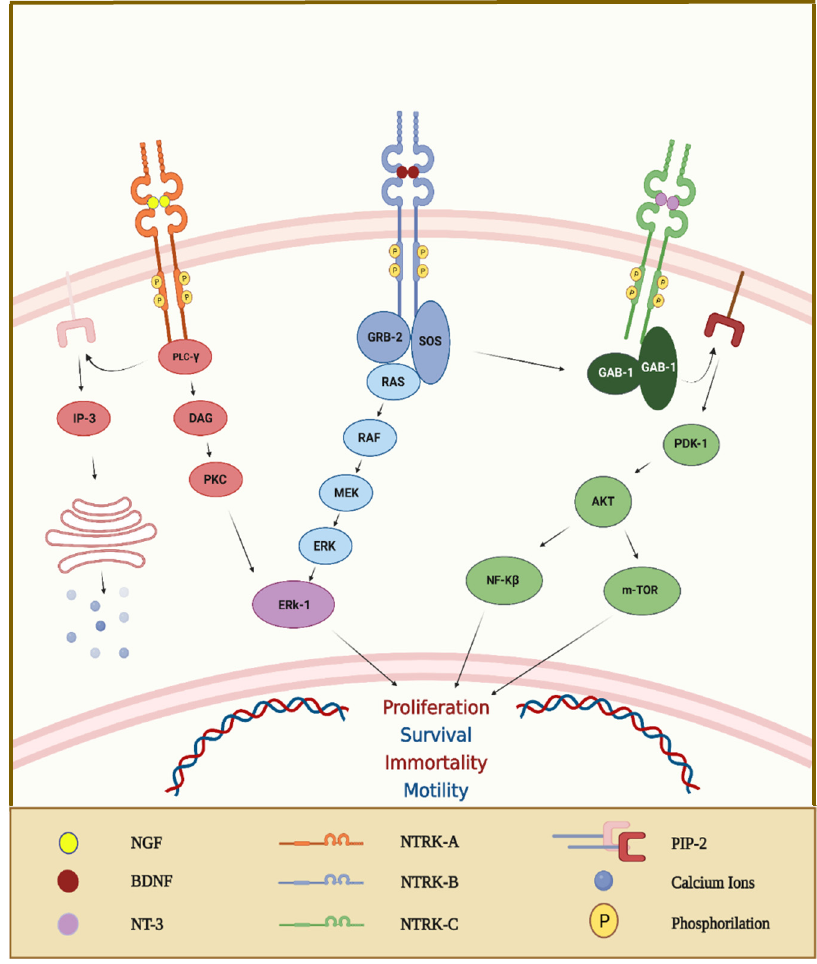
Figure 3. The interaction between ligands and TRK receptors generates TRK receptor dimerization, activating crosstalk between multiple intracellular signaling pathways involving PI3K and mitogen- activated protein kinase pathways. Abbreviations: protein kinase B (AKT); diacylglycerol (DAG); extracellular signal-regulated kinase (ERK-1); GRB2-associated binding protein-1 (GAB-1); growth factor receptor-bound protein-2 (GRB-2); inositol trisphosphate (IP-3); mitogen-activated protein kinase kinase (MEK); mammalian target of rapamycin (m-TOR); nuclear factor kinase- β (NF-K β ); 3-phosphoinositide-dependent protein kinase-1 (PDK-1); protein kinase C (PKC); phospholipase C- γ (PLC- γ ); rapidly accelerated fibrosarcoma (RAF); rat sarcoma virus (RAS); Son of sevenless (SOS). “Created with BioRender.com”.